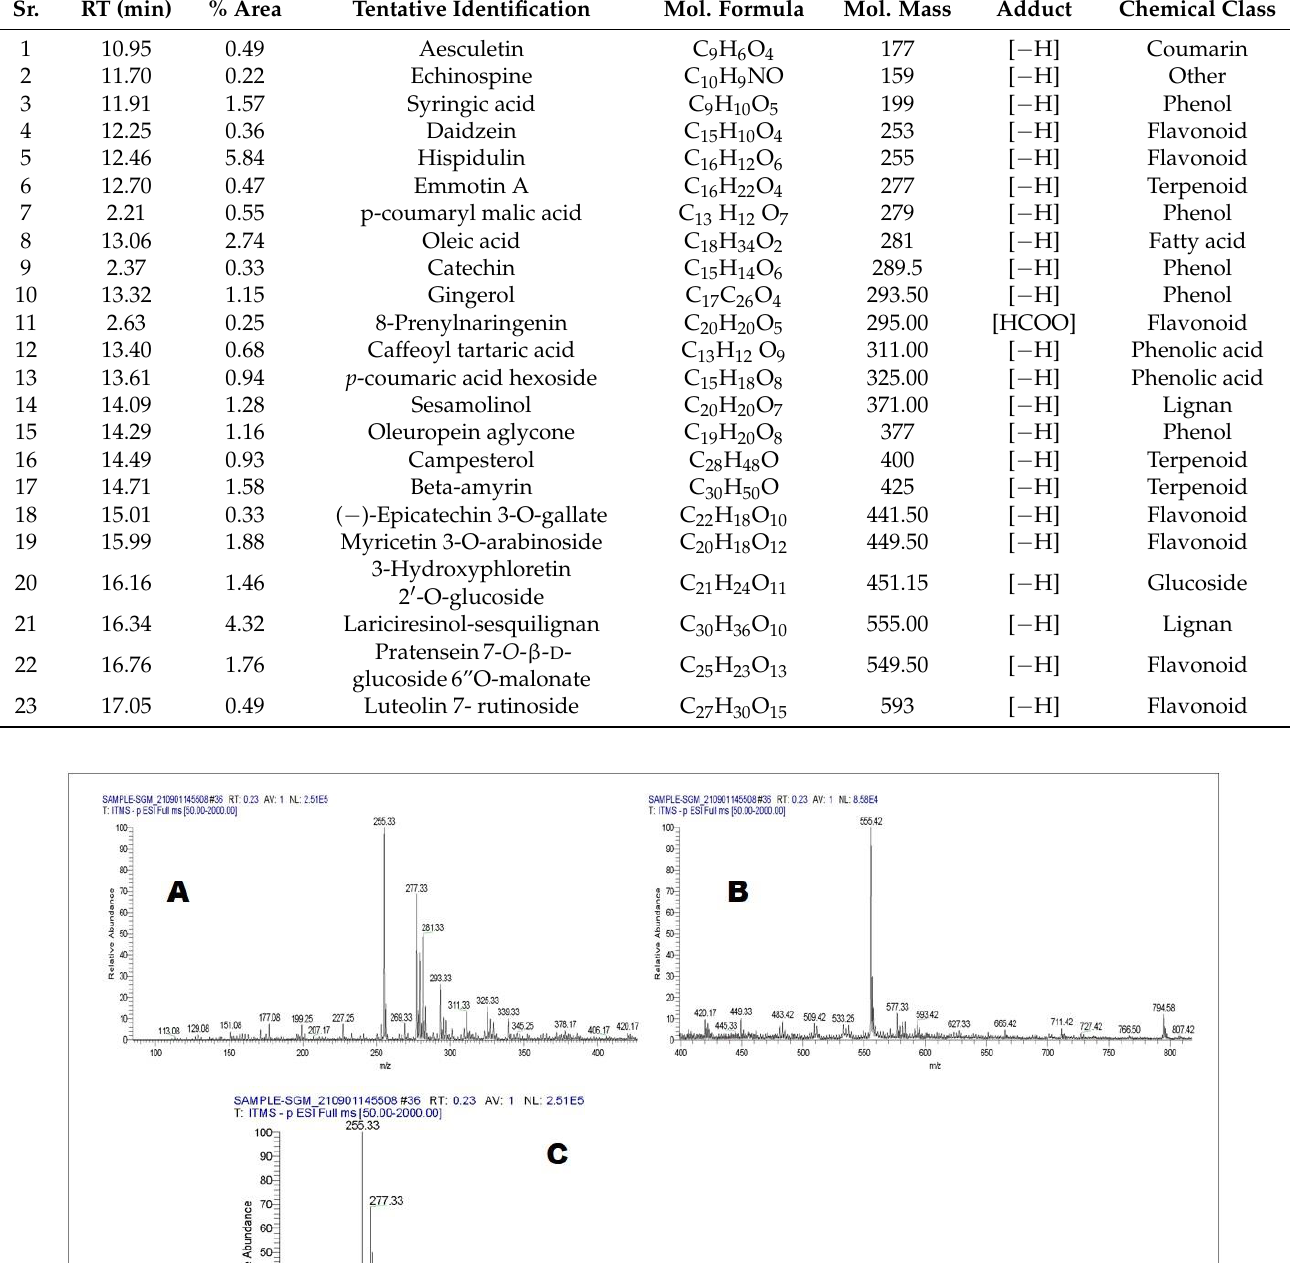
Table 3. LC-ESI-MS-MS screening of Strobilanthes glutinosus in negative mode. Table 4. LC - ESI-MS-MS screening of Strobilanthes glutinosus in positive mode.